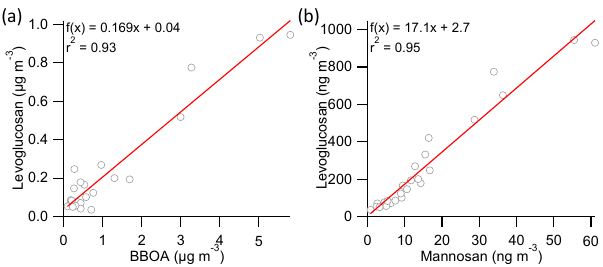
Figure 10. Correlations between levoglucosan and (a) BBOA and (b)